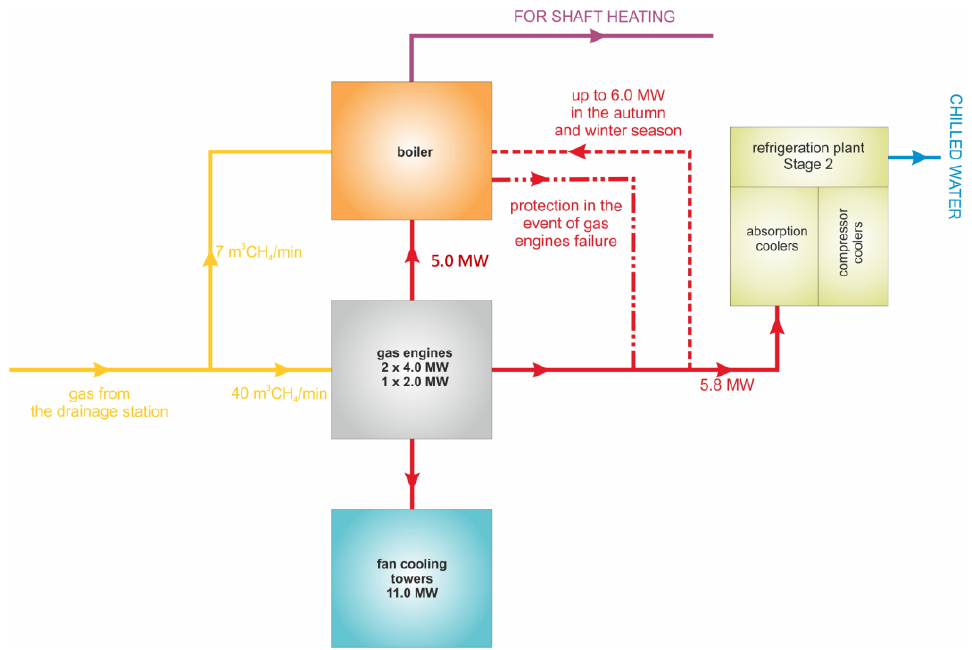
Figure 9. Heat and methane flow between the cogeneration system, a central air-conditioning plant, and a heating plant.